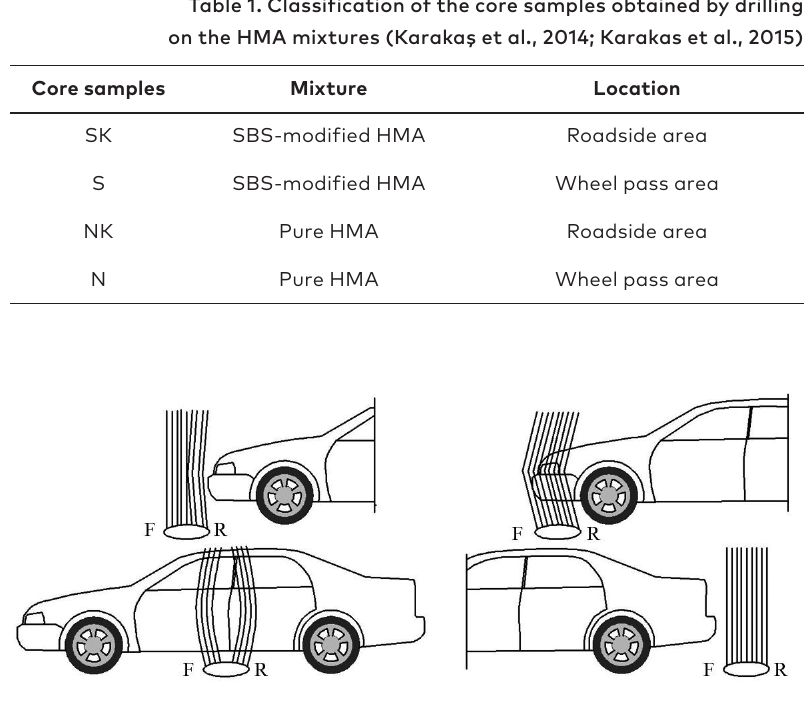
Figure 2. Magnetic imaging of vehicle movements by the sensors of the NC 100-200